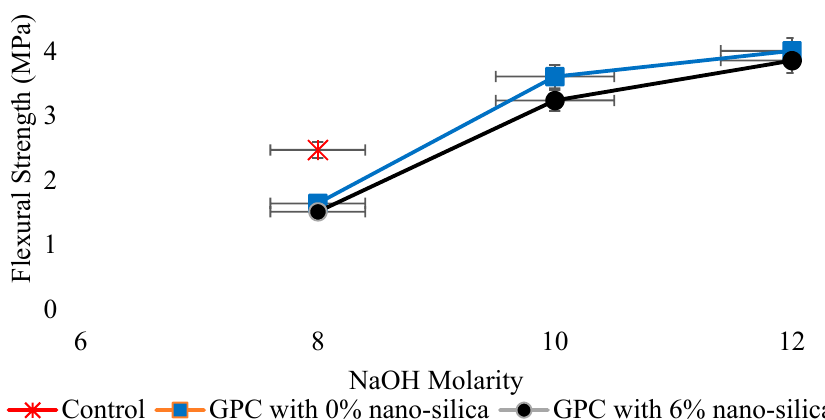
Figure 15. Relation of flexural strength with molar concentration, modified from [140]; Elsevier, 2014.